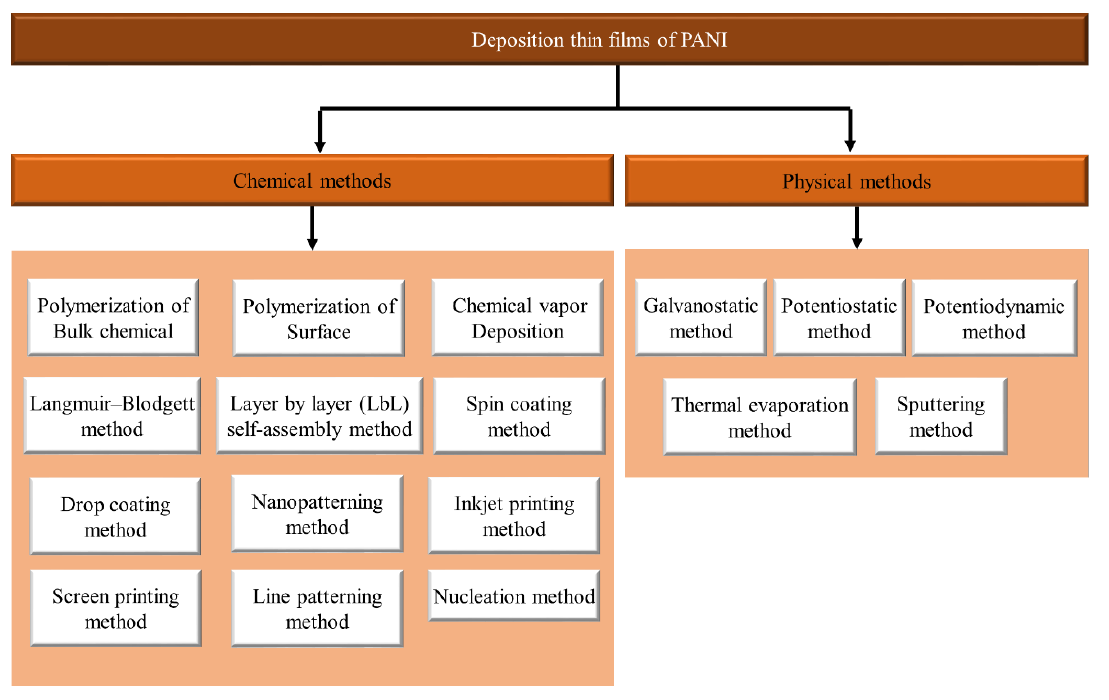
Figure 16. Different methods of thin-film deposition of PANI.